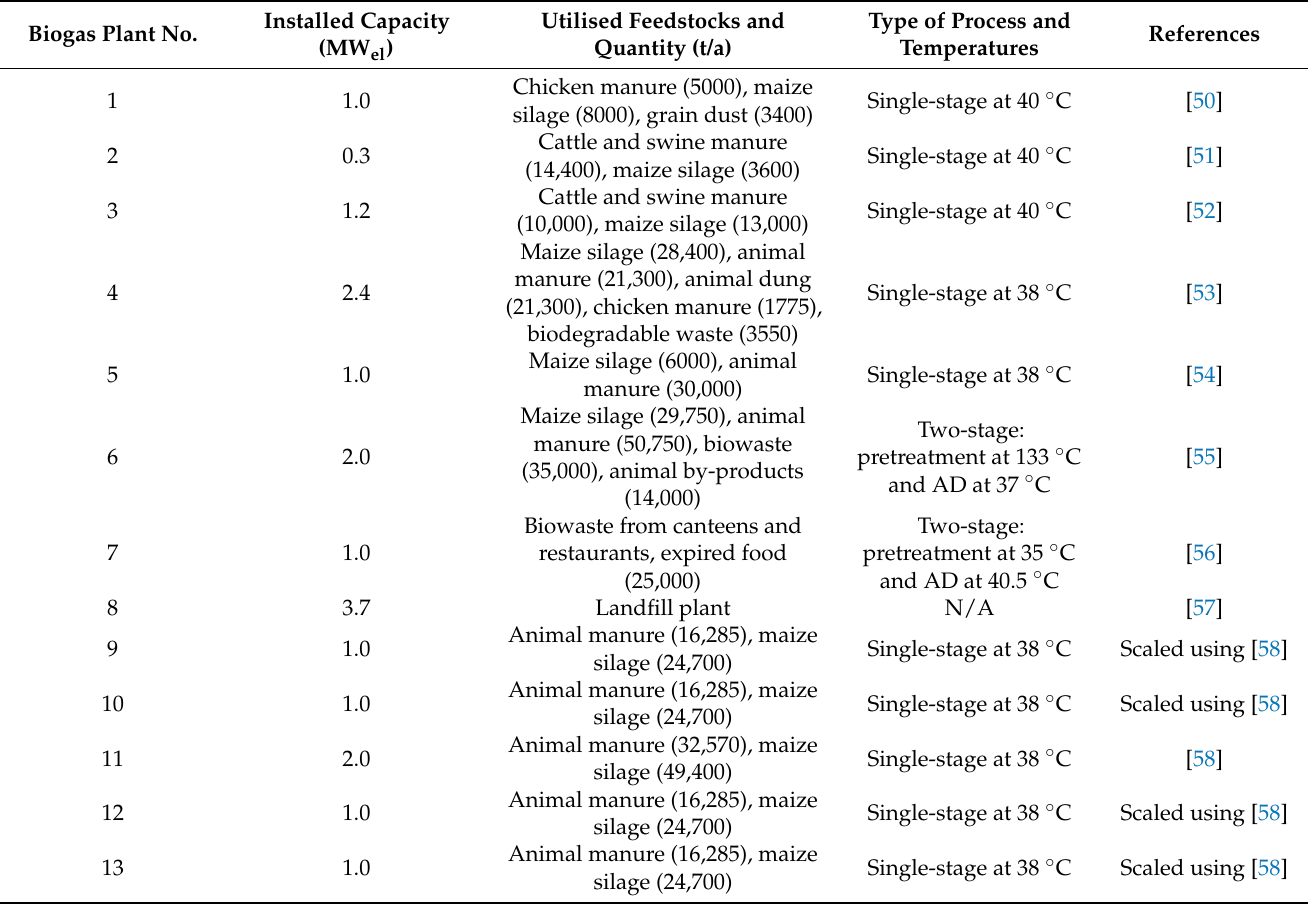
Table 1. Biogas plants in the case.